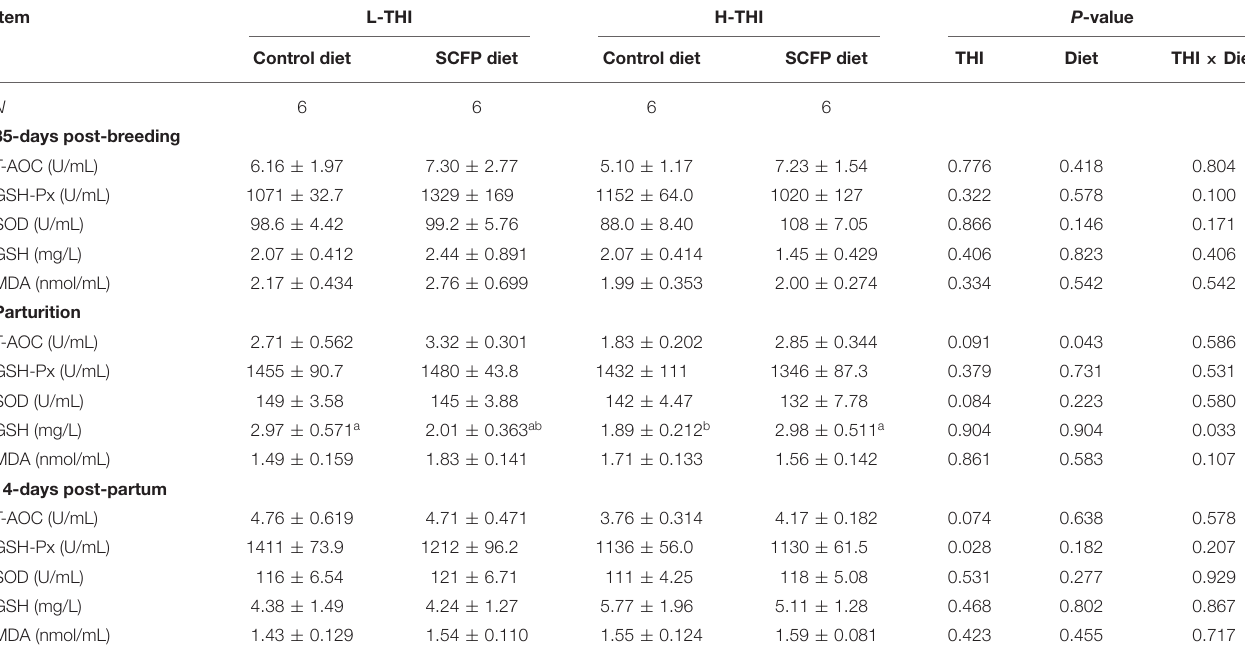
TABLE 6 | Effects of dietary supplementation of Saccharomyces cerevisiae fermentation product during late pregnancy and lactation on antioxidant status in serum of sows in a subtropical climate (Mean ± SE).